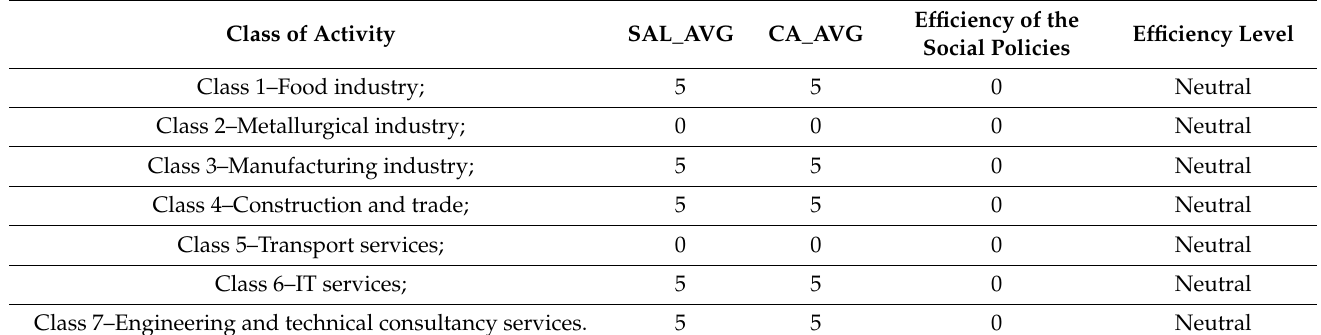
Table 6. Evaluating the effectiveness of social